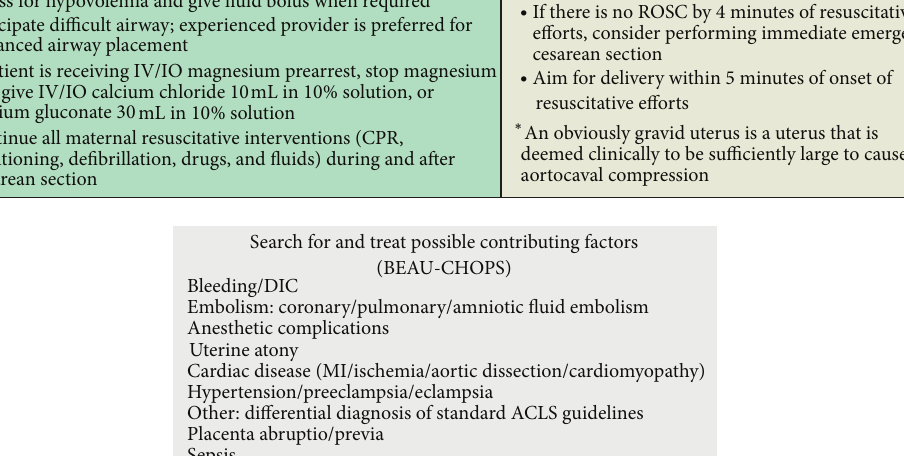
Figure 1: Maternal Cardiac Arrest Algorithm